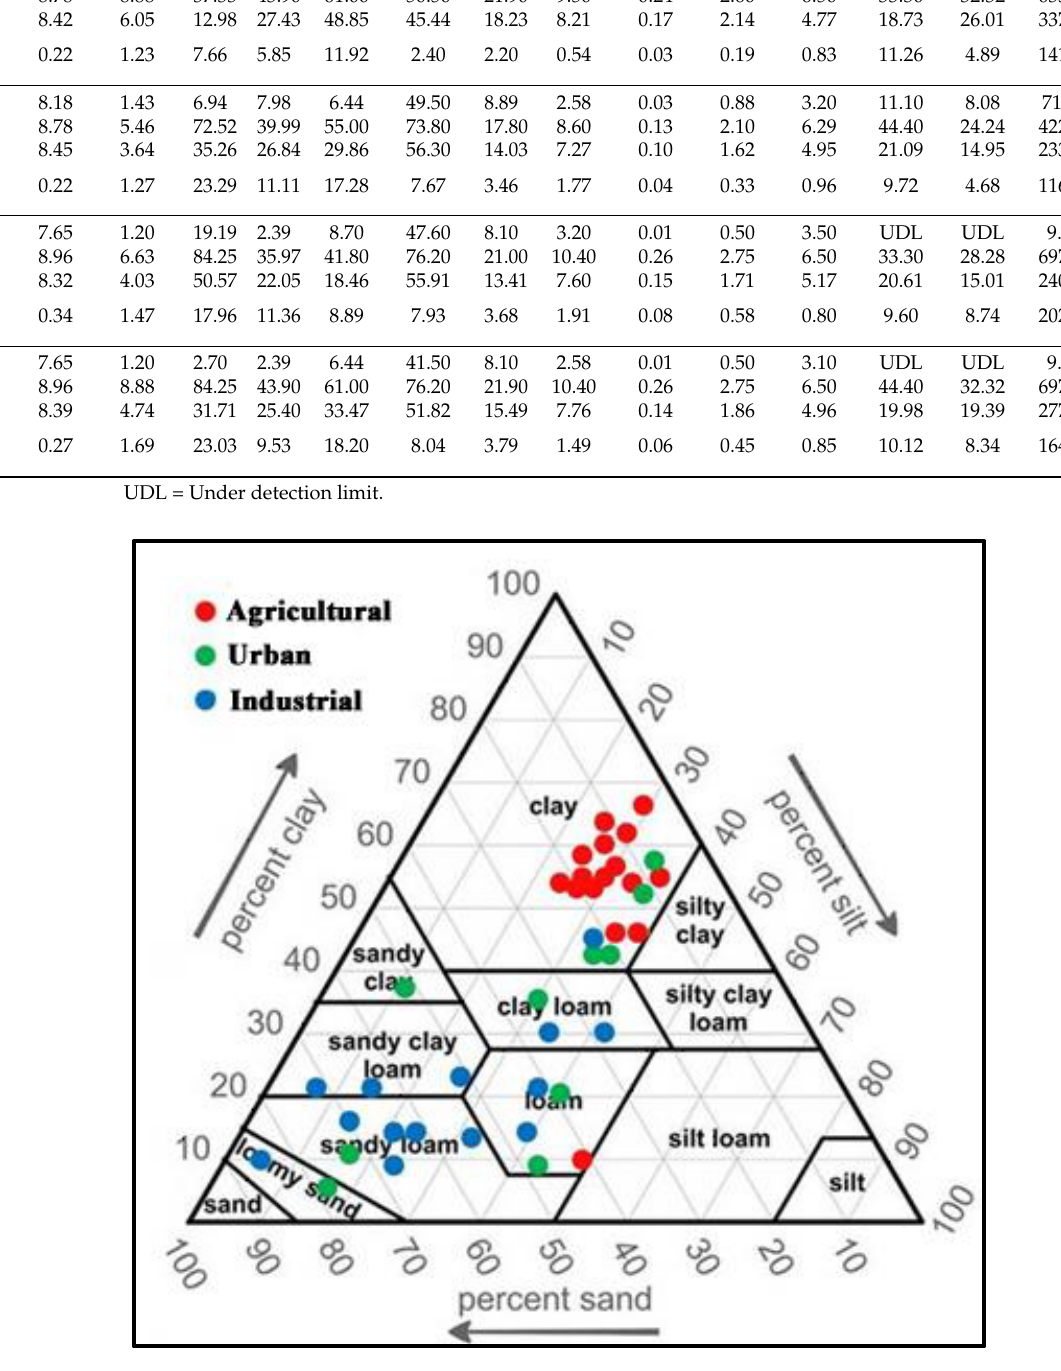
Figure 2. Classification of the studied soil samples [41].